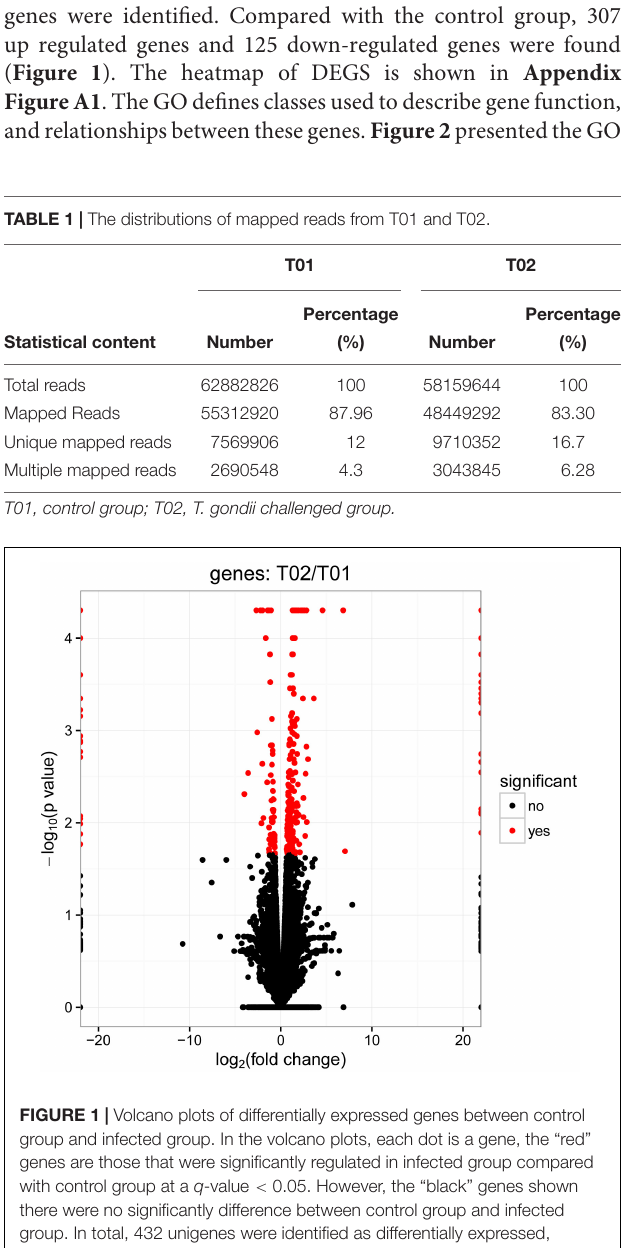
and relationships between these genes. Figure 2 presented the GO